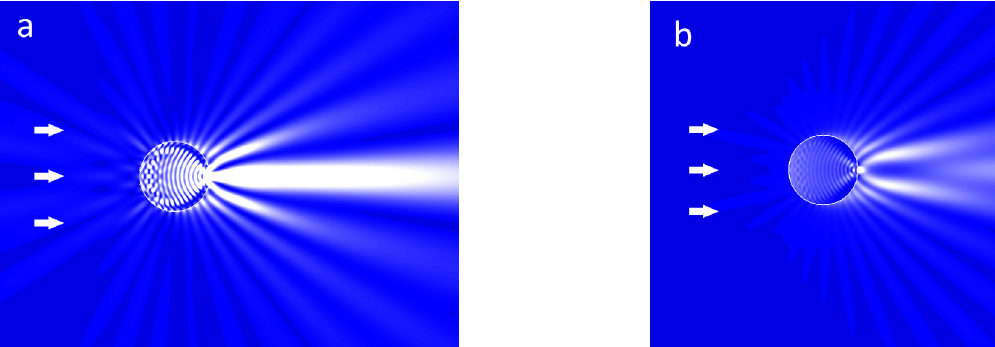
Figure 6. Visualization of the intensity distribution of a wave scattered by a 2 µm thick crystal for two cases considered in the experiment: ( a ) λ = 400 nm, μ − 1 = 30 µm, ( b ) λ = 350 nm, μ − 1 = 1 µm. The arrows show the direction of the incident light.